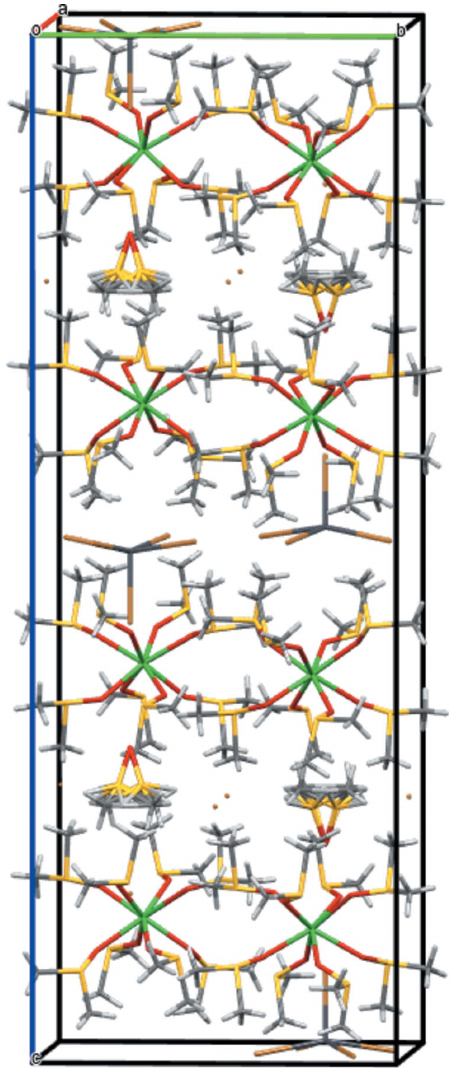
Figure 2 Perspective view of the precursor crystal structure along [100].